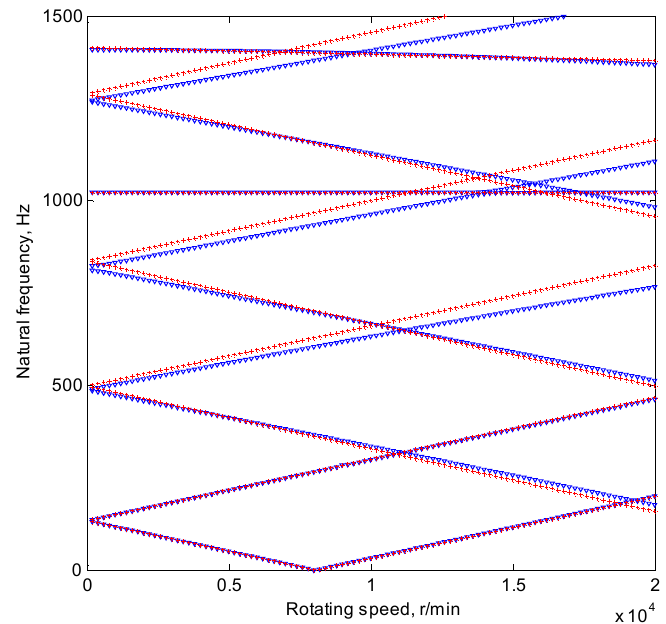
Figure 8. The Campbell diagram of the rotor-bearings system with a 20-mm crack. and denote